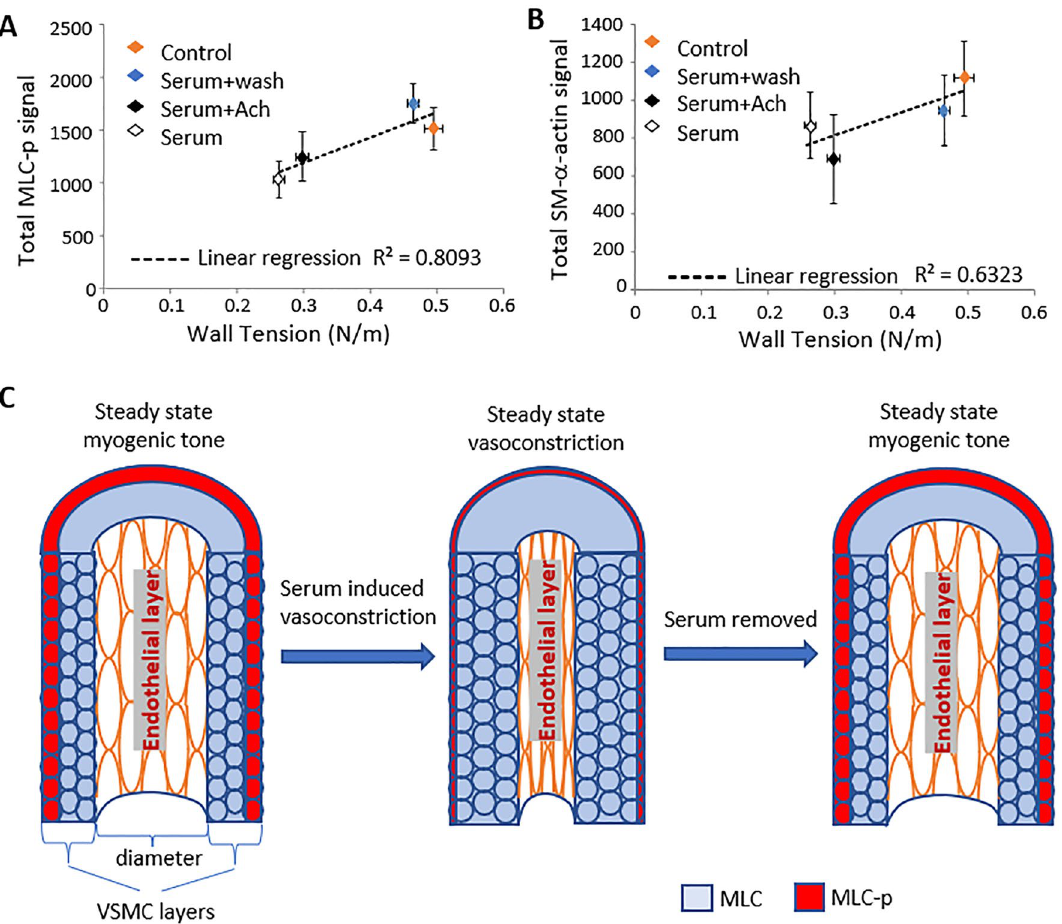
Figure 8. Correlation of wall tension vs. total MLC-p and total SM-α-actin among the four treatment groups of SCAs. Wall tension was calculated following LaPlace’s law, T = p*r, where T is wall tension, intraluminal pressure (p) is 70 mmHg, and r is the vessel radius measured before fixation. ( A ) Plot of wall tension vs. total MLC-p fluorescence intensity. ( B ) Plot of wall tension vs. total SM-α-actin fluorescence intensity. Data are presented as Mean ± SEM; Wall tension: n = 12 vessels each for control and serum-treated groups; n = 7 for the serum + Ach group and n = 5 for the serum washout group. Total MLC-p: n = 6 vessels each for the control and serum-treated groups; n = 7 for the serum + Ach group and n = 4 for the serum washout group. Total SM-α-actin: n = 5 vessels each for control, serum, serum washout and serum + Ach groups. ( C ) Schematic showing the observed